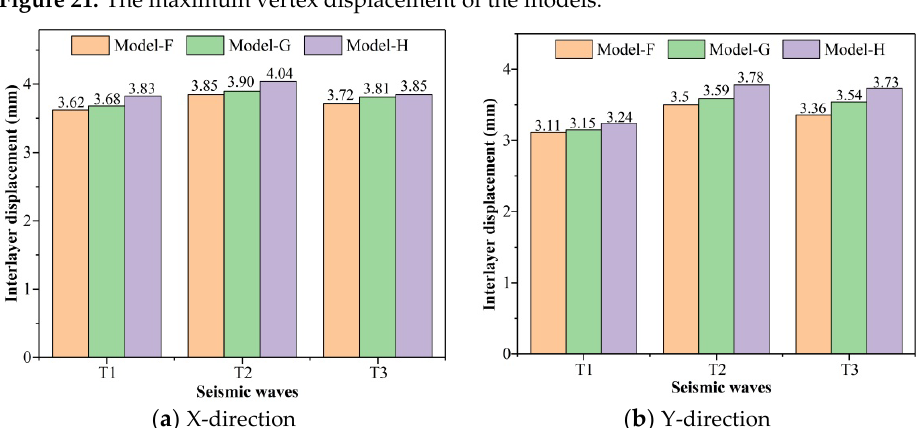
Figure 21. The maximum vertex displacement of the models.